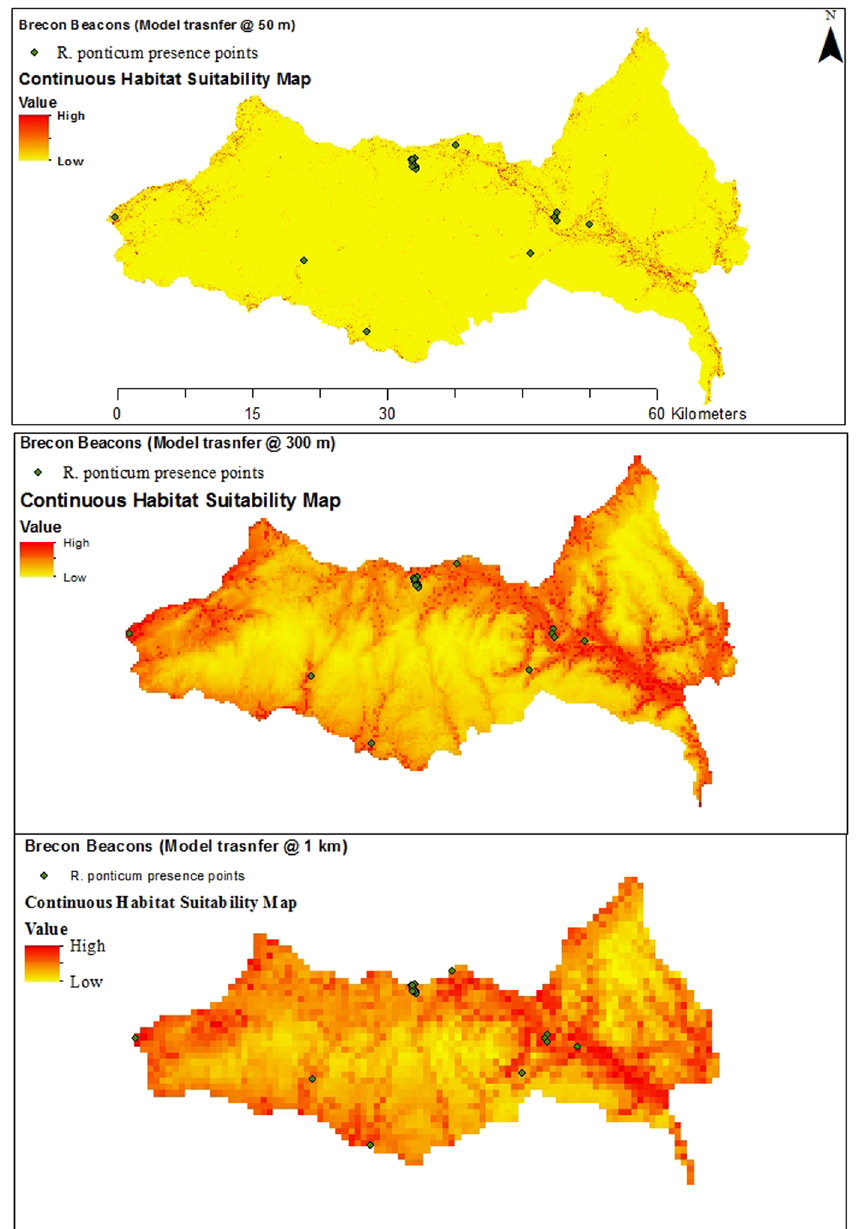
Figure 2. Rhododendron ponticum habitat suitability maps at 1 km, 300 m and 50 m resolutions generated in ArcGIS 10.5 (ESRI, Redlands, CA, USA, www.esri.com). A spatial distribution model was trained in Snowdonia National Park and transferred to the Brecon Beacons National Park. Blue dots indicate verified occurrence records of the